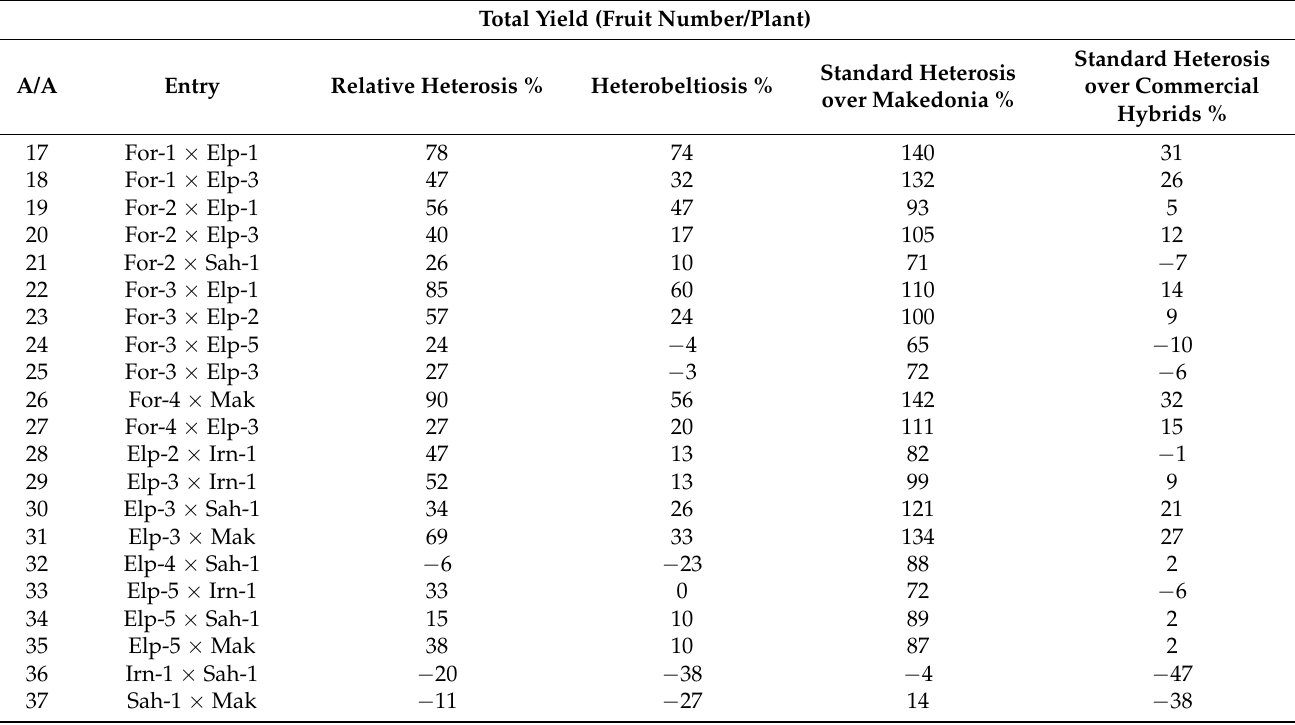
Table 7. Relative heterosis, heterobeltiosis, and standard heterosis of the reconstructed new hybrids for total yield (fruit number/plant).